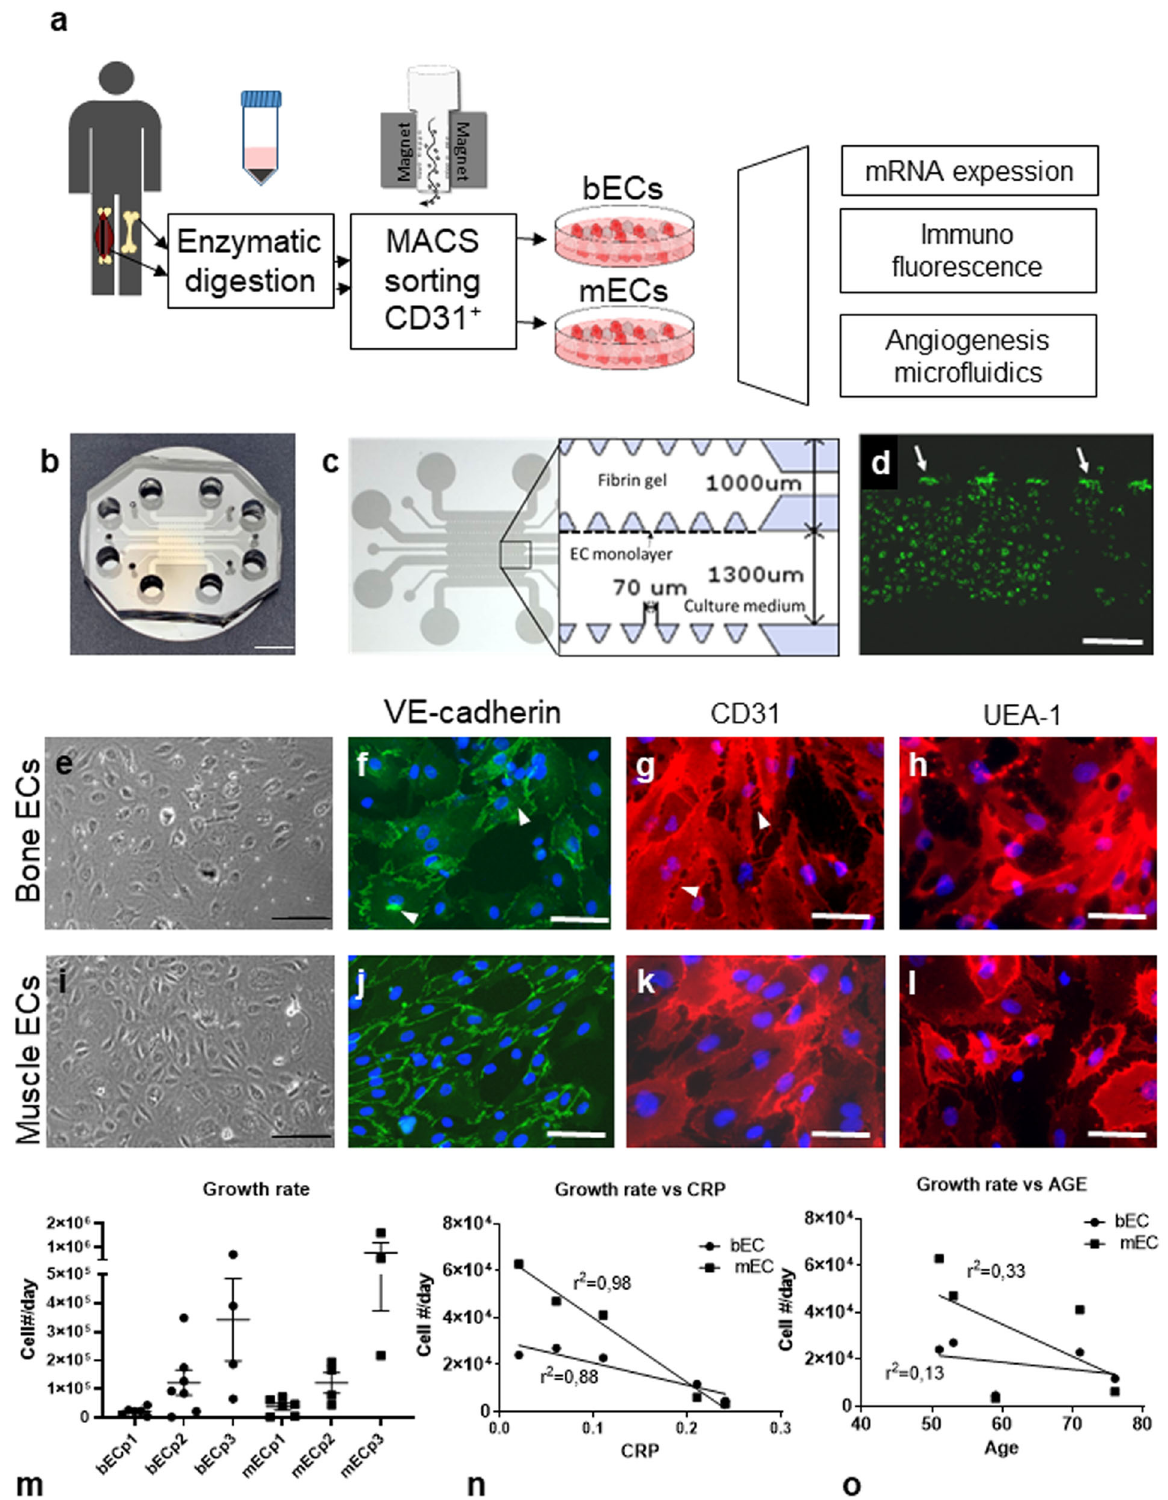
Fig. 1 Study schematics, micro fl uidic device images and cell characterization. a Schematics of experimental procedures. b Image of the fabricated micro fl uidic chip. Scale bar 500 μ m. c Schematics of the chip channels. d Fluorescence image of a monolayer of endothelial cells on the chip channel (green). White arrows indicate the areas in which the monolayer contacts the fi brin gel. Scale bar: 250 μ m. e – l Characterization of cultured bECs and mECs: e – i Phase contrast images. Scale bars 100 µ m. f – j VE-cadherin staining (green, blue: DAPI). g – k CD31 staining (red, blue: DAPI). h – l UEA-1 staining (red, blue: DAPI). Scale bars 50 µ m. m Growth rate of bECs and mECs over the fi rst three passages ( n = 3 – 6). Data are represented as mean and SEM. n Correlation between growth rate at the fi rst passage and CRP values of the patients ( n = 5, p = 0.0187 and p = 0.001 for bECs and mECs respectively). o Correlation between growth rate at the fi rst passage and patient age ( n = 5, p = 0.55 and p = 0.30 for bECs and mECs